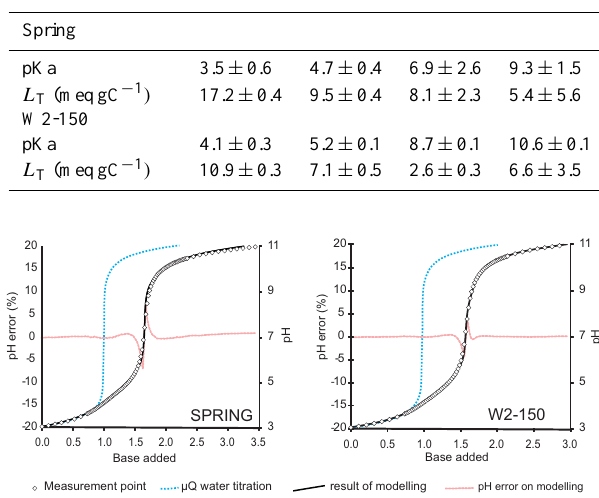
Fig. 6. Microtitration curves of DOM-rich groundwaters and result of modeling with the PROSECE